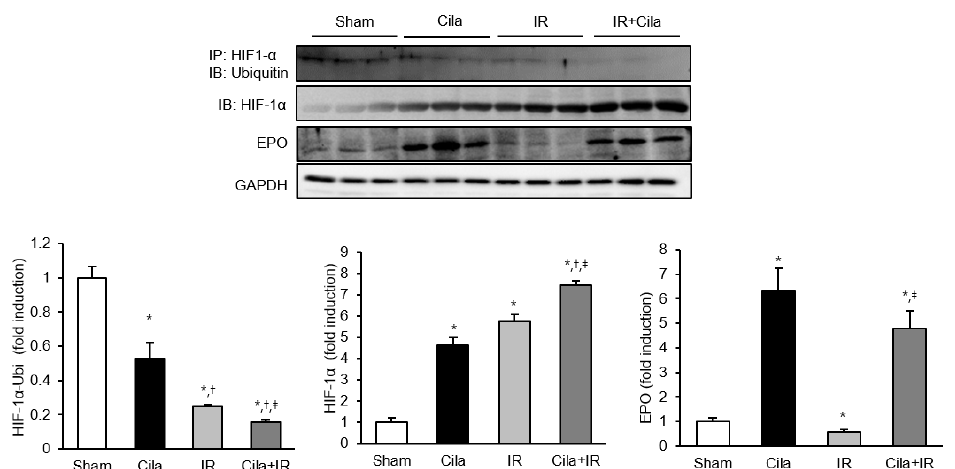
Figure 6. Cilastatin preconditioning upregulated HIF-1 α expression and its downstream signaling pathway and decreased the ubiquitination of HIF-1 α in mouse kidney with IR injury. Immunoprecipitation showed that HIF-1 α / ubiquitin complex formation was significantly decreased in mouse kidney with IR injury compared to sham-operated mice; however, it more significantly decreased in cilastatin-treated mouse kidney with IR injury. Therefore, semiquantitative immunoblotting revealed that HIF-1 α expression markedly increased in cilastatin-treated mouse kidney with IR injury compared to other groups. EPO expression was significantly increased in cilastatin-treated mouse kidney and was decreased in mouse kidney with IR injury; however, it increased in cilastatin-treated mouse kidney with IR injury. The data are presented as means ± SEM.* p < 0.05 vs. sham group; † p < 0.05 vs. Cila group; ‡ p < 0.05 vs. IR